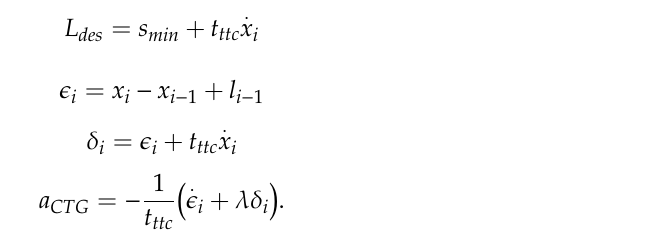
Figure 7. Comparison of measured deceleration and constant acceleration model.